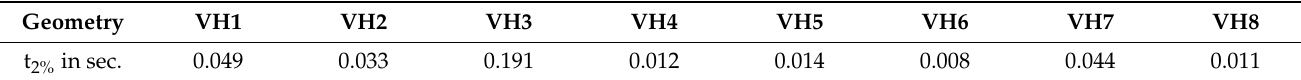
Table 2. The 2% settling times of geometries.